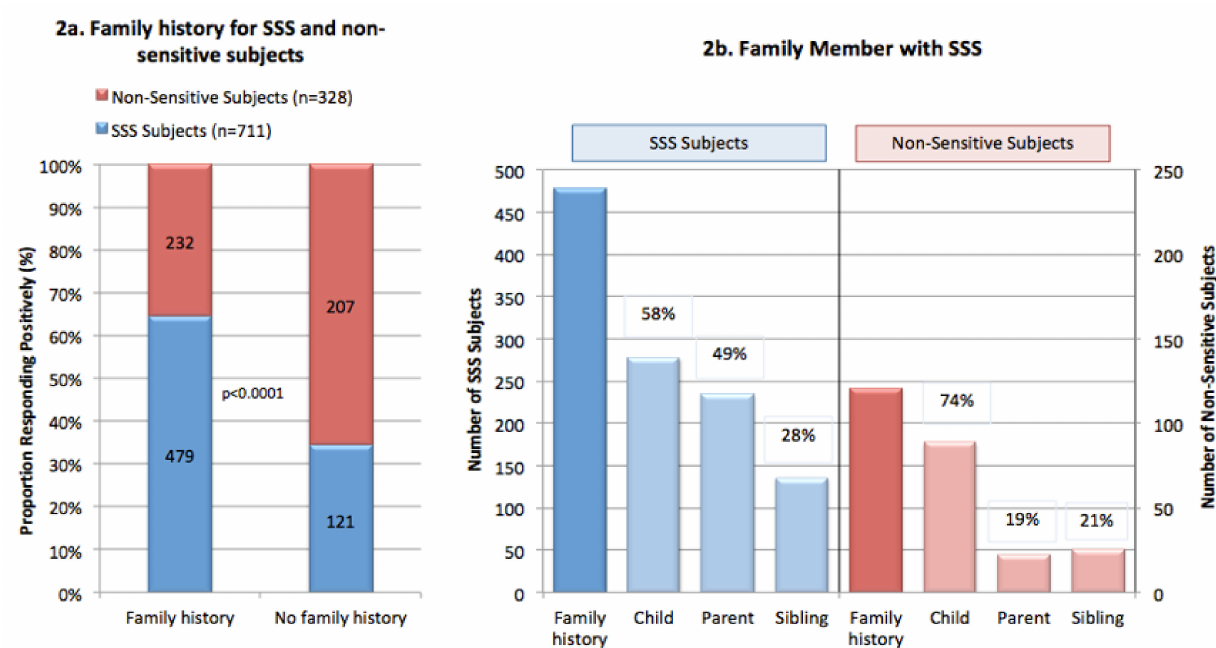
Figure 2. Family history and SSS. ( a ) In the Cincinnati study, 711 individuals claimed some degree of skin sensitivity (very, sensitive, or slightly), and 328 responded that their skin was not sensitive [54]. When asked if they had a family history of skin sensitivity, 63% of the SSS group (479/711) responded positively compared to 37% of the non-sensitive group (121/207). This difference was significant ( p < 0.0001). ( b ) When asked which family member(s) also had SSS, the most common response was a child for both the SSS and the non-sensitive